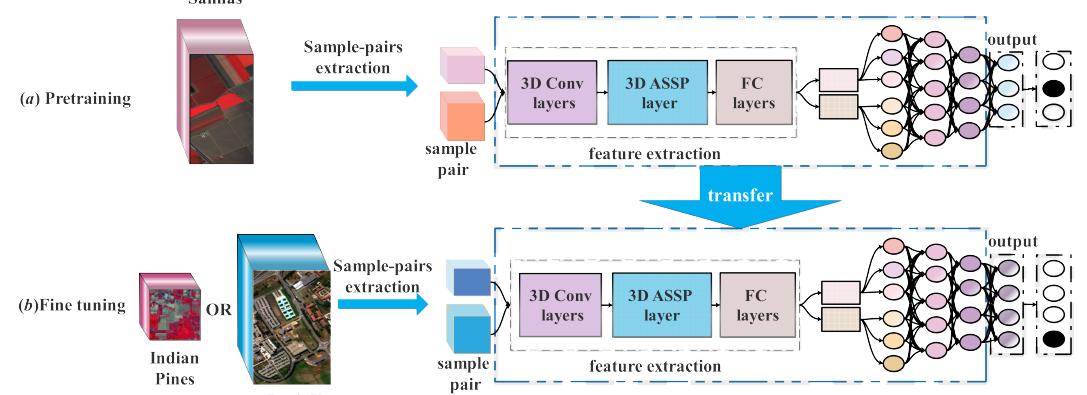
Figure 8. Transfer learning strategy based on ASSP-SCNN. ( a ) Pre-training an ASSP-SCNN in source HSI dataset with limited labeled samples. Here the target HSI dataset and source HSI dataset can be collected by the different sensors. ( b ) Fine-tuning strategy. After ASSP-SCNN is pre-trained, we transfer the entire model except for the output layer to the network built for target HSI dataset as initialization. We then fine-tune the transferred part and the new output layer on target HSI